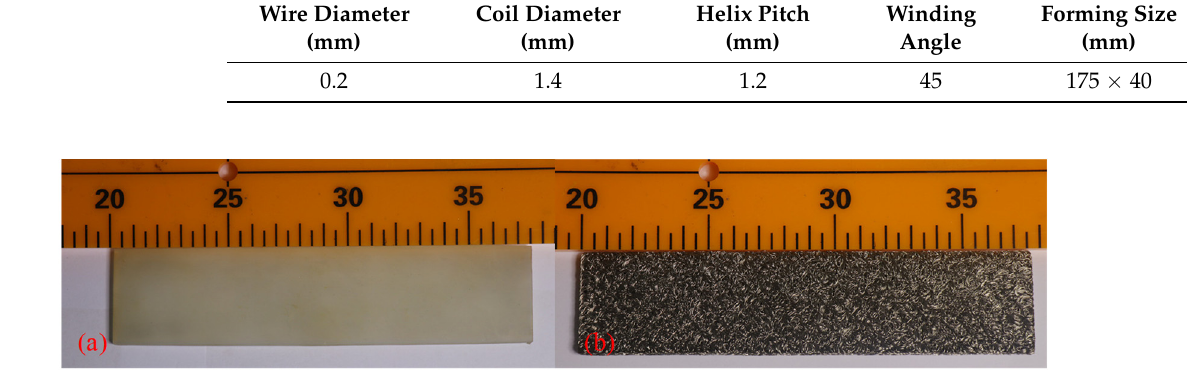
Figure 5. Specimen dimensions: (a) specimen of SR; (b) specimen of MR.